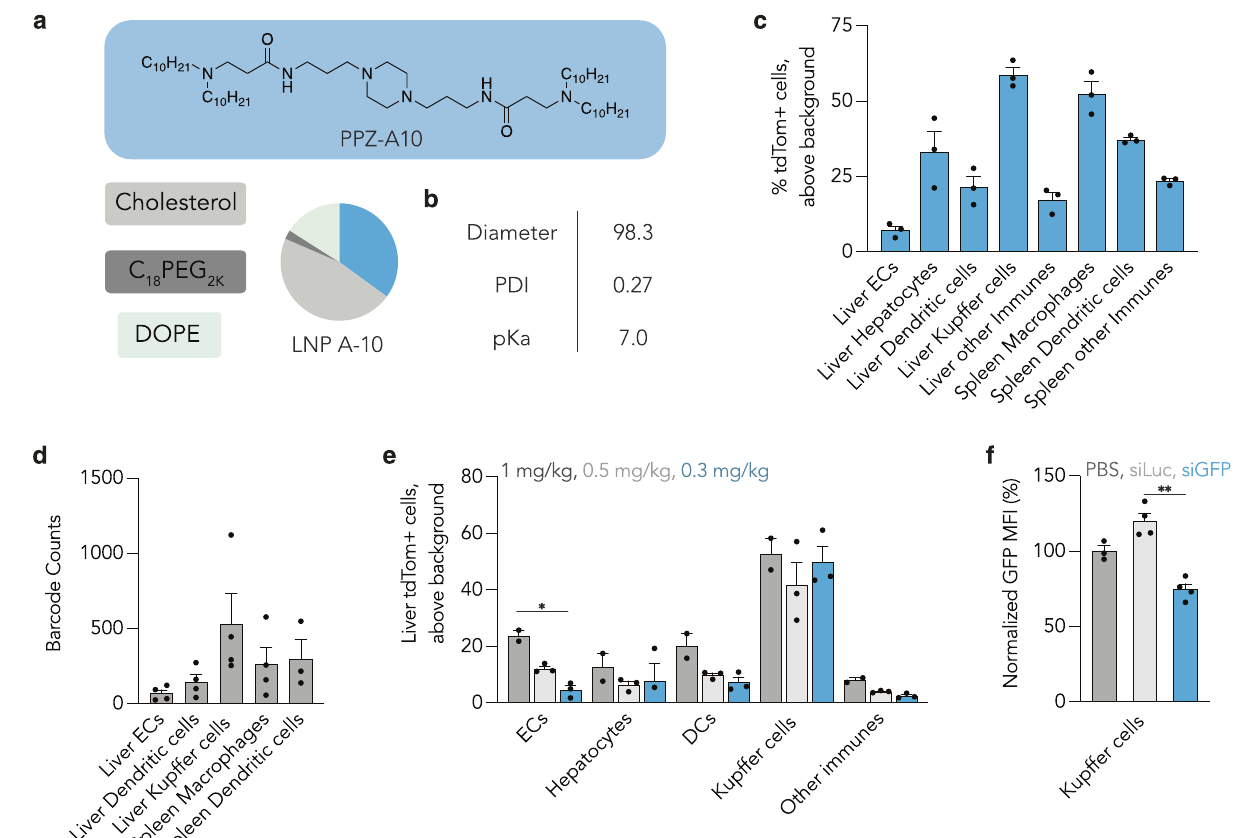
Fig.3|LNPscontainingpiperazine-basedlipidsdelivermRNAtoimmunecells. a A top-performing LNP-A10 with PPZ-A10, cholesterol, C 18 PEG 2K and DOPE at a ratio of 35:46.5:2.5:16 was identi fi ed and formulated with Cre mRNA. b The dia- meter(nm),polydispersityindex(PDI),andpKaofLNP-A10. c LNP-A10wasinjected to Ai14 mice at a dose of 1mg/kg, and %tdTomato+ cells in liver endothelial cells (ECs), hepatocytes, dendritic cells, Kupffer cells, other immunes and spleen mac- rophages, spleen dendritic cells and spleen other immunes were quanti fi ed after three days. N =3/group, average+SEM. Source data are provided as a Source Data fi le. d Biodistribution of LNP-A10 in liver ECs, dendritic cells, Kupffer cells, spleen